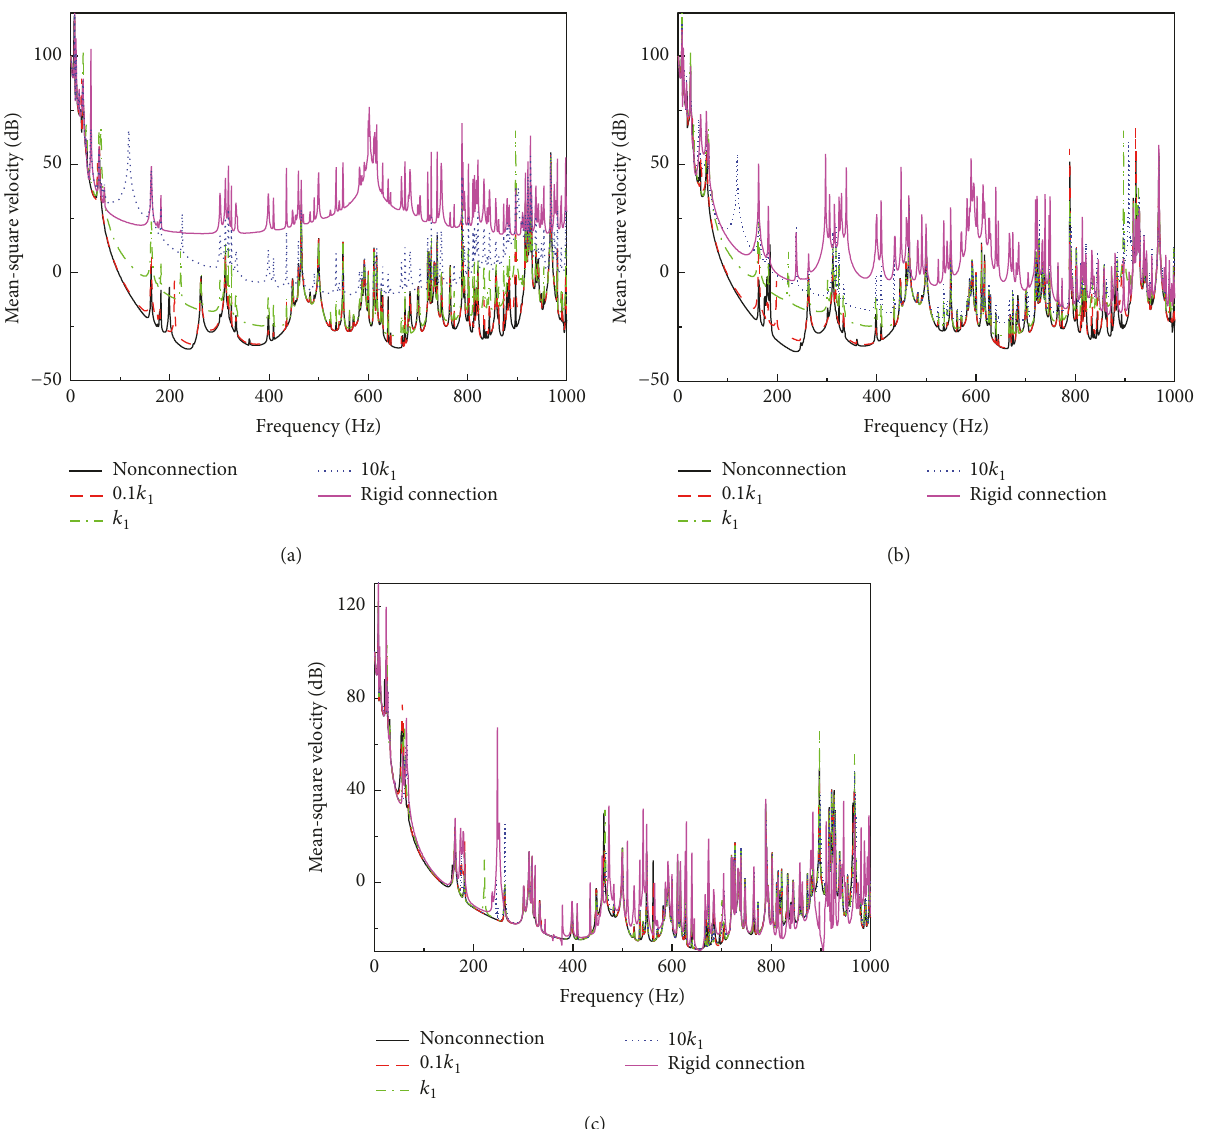
Figure 12: Effects of the connection stiffness of attached pipes on the synthesis results: (a) the stiffness of isolator between attached pipes and machine; (b) the stiffness of isolator between attached pipes and hull; (c) the stiffness of isolator between attached pipes and